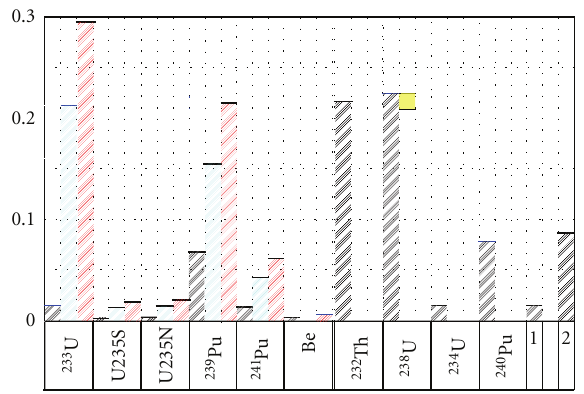
Figure 4: Liquid metal-cooled reactor neutron balance in campaign with equilibrium by fuel nuclides regime.